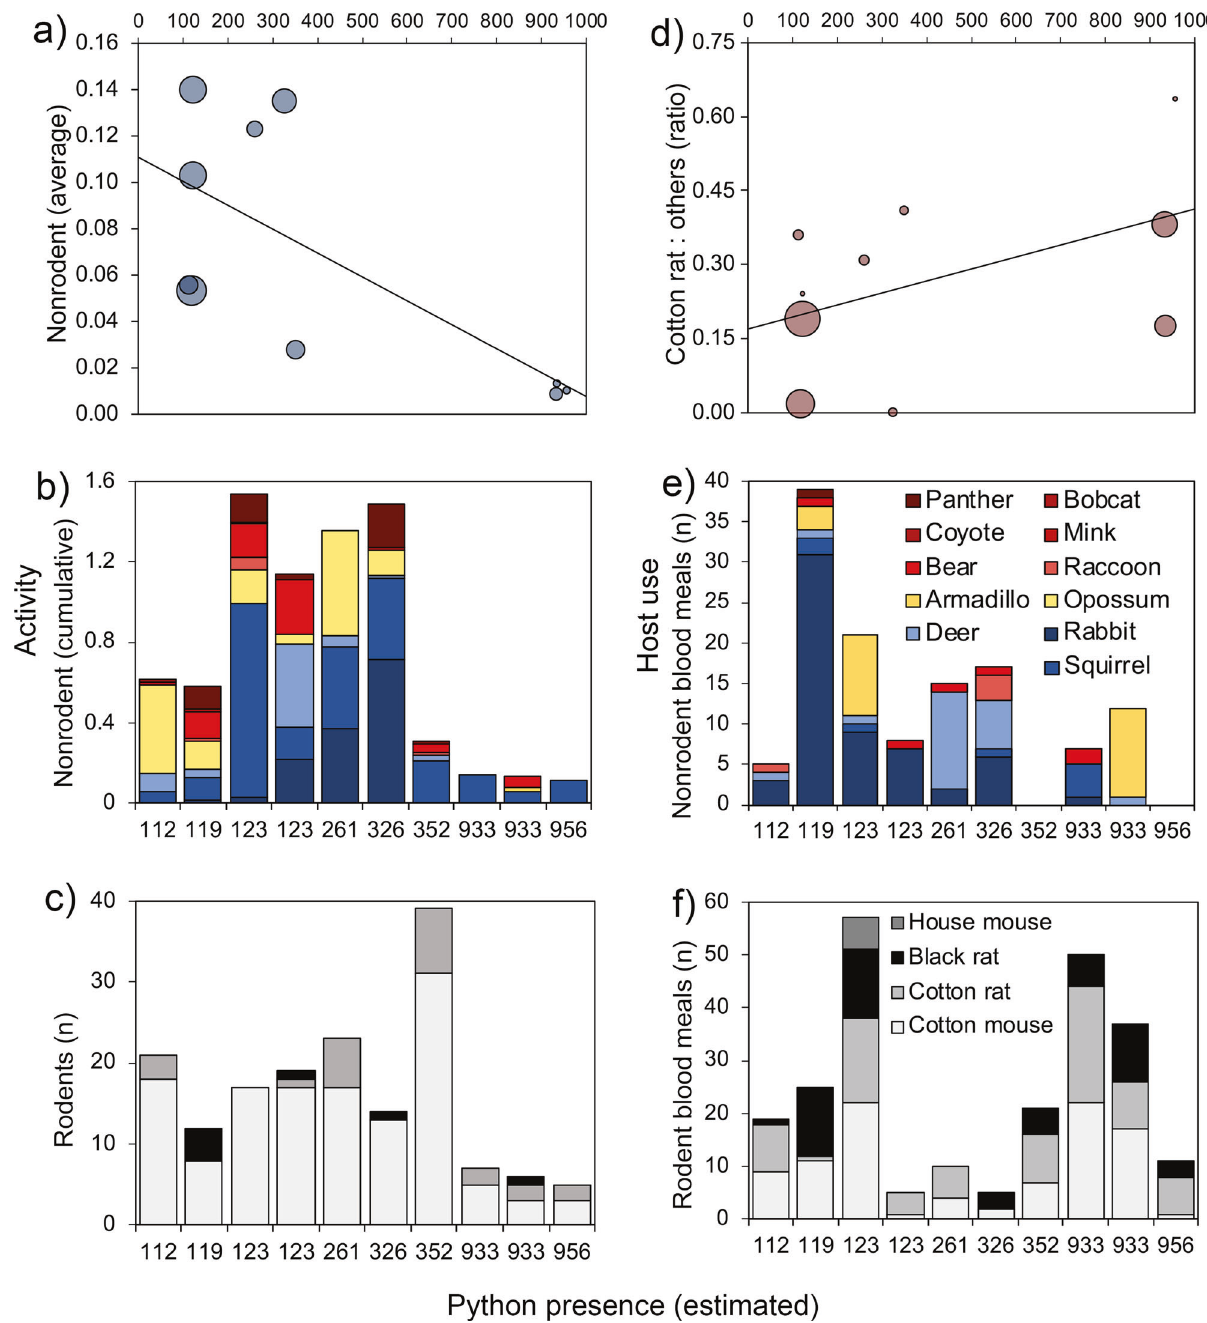
Fig. 3 Mammal activity and host use at sites with varying relative probability of Burmese python presence. Average ( a ) and cumulative ( b ) non-rodent activity was quanti fi ed through camera trapping along corridors. Rodent activity ( c ) was quanti fi ed using Sherman traps. Host use as a function of the proportion of blood meals from cotton rats to other mammals ( d ), non-rodents ( e ), and rodents ( f ) was determined through PCR-based analysis of blood- engorged Culex cedecei females. Values of the relative probability of python presence were generated by a species distribution model using an ensemble modeling approach that combined model outputs from multiple SDM algorithms, executed in the “ biomod2 ” package in R. Points in ( a ) and ( c ) are scaled by total activity and numbers of blood meals,